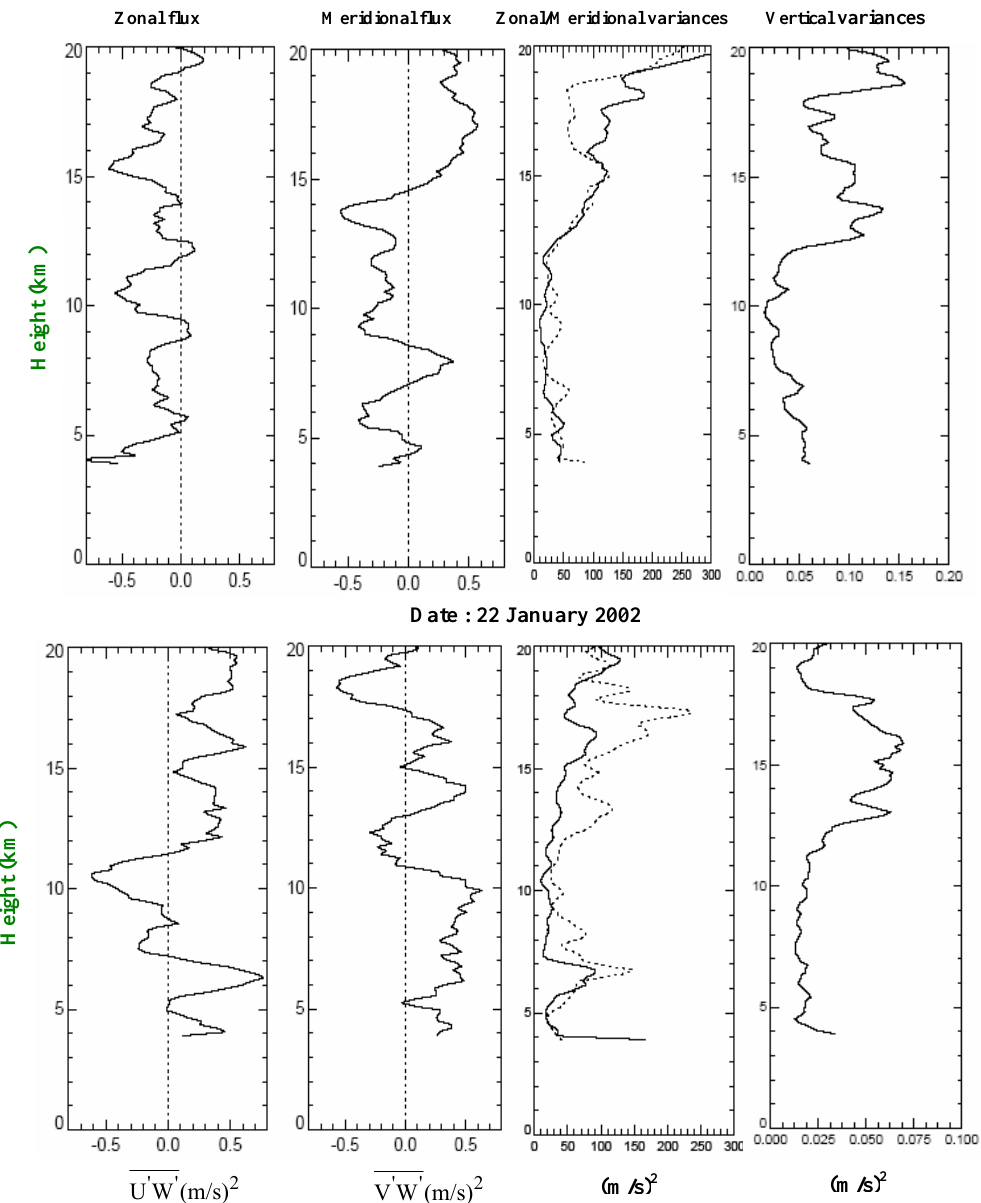
Fig. 13. Momentum flux and variance of wind fluctuations estimated from the MST radar data during 10:00–16:00 LT on 17 July 2001 (upper panel) and 22 January 2002 (lower panel). Six hours of observations are averaged. Dotted line represents the meridional variance and the solid line represents the zonal